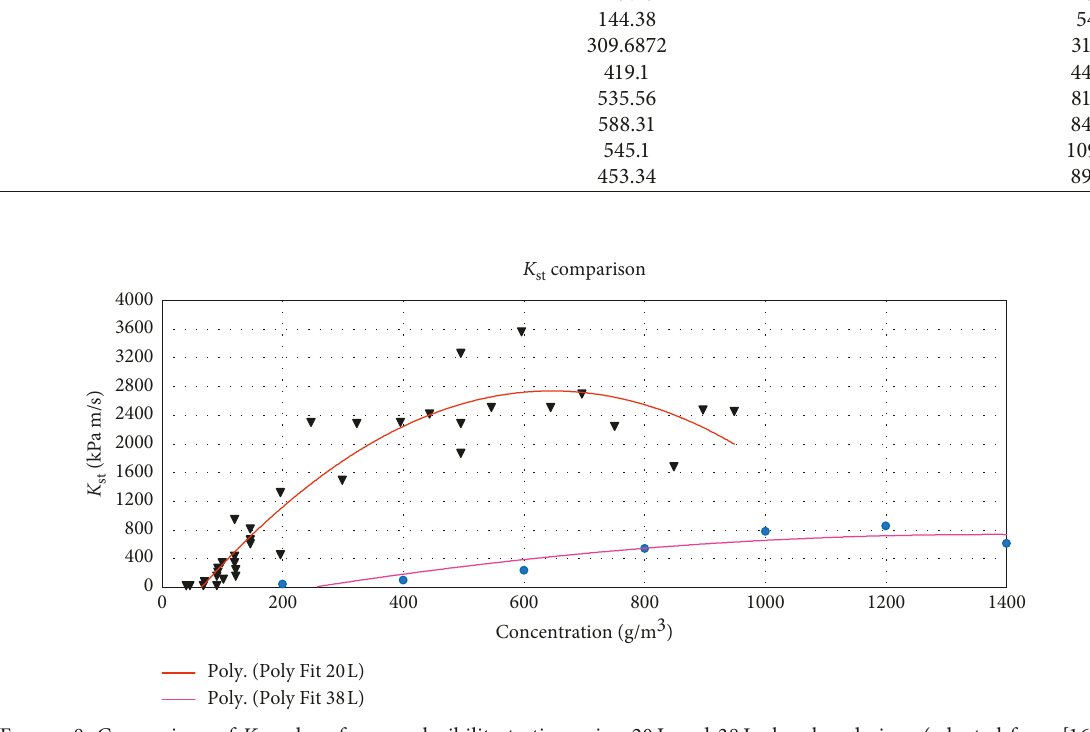
Figure 8: Comparison of K st values from explosibility testing using 20L and 38 L chamber designs (adapted from